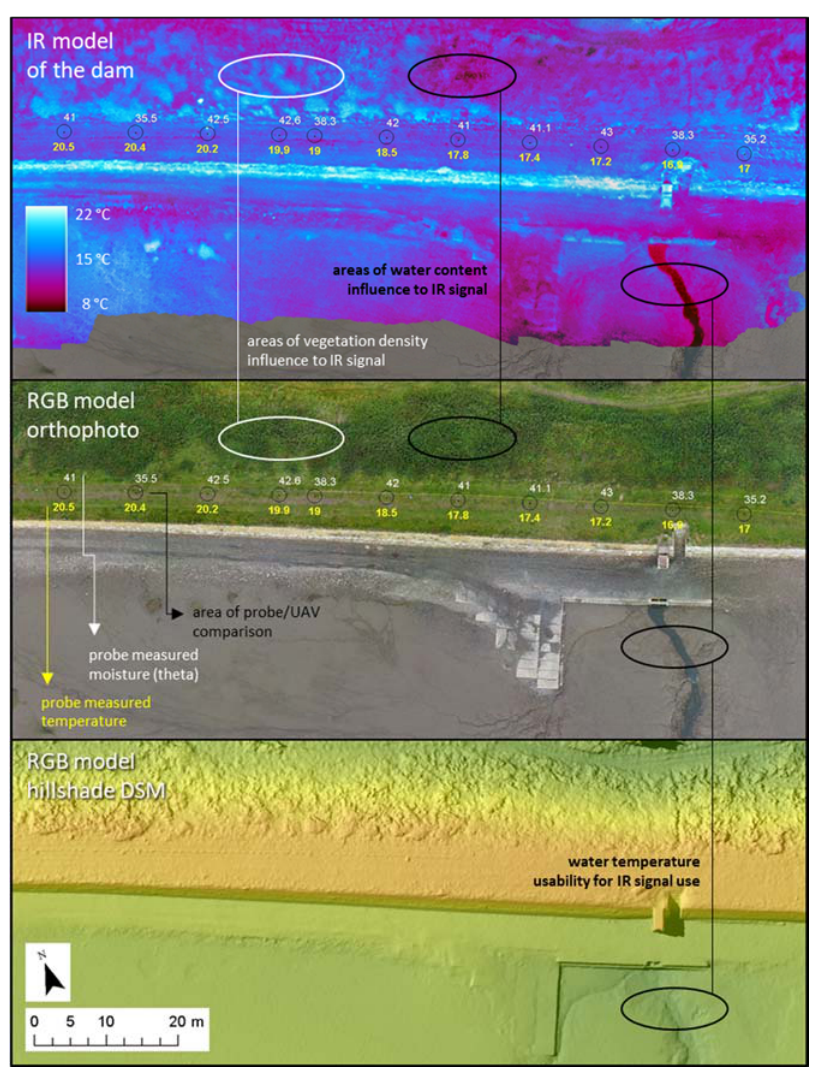
Figure 3. Overview of the results of the dam